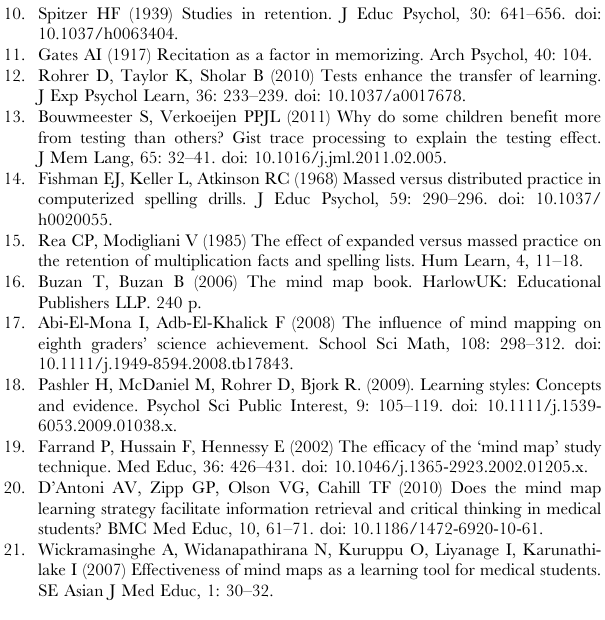
Table S1 Numbers and ages of children per year group in each of the two experiments.